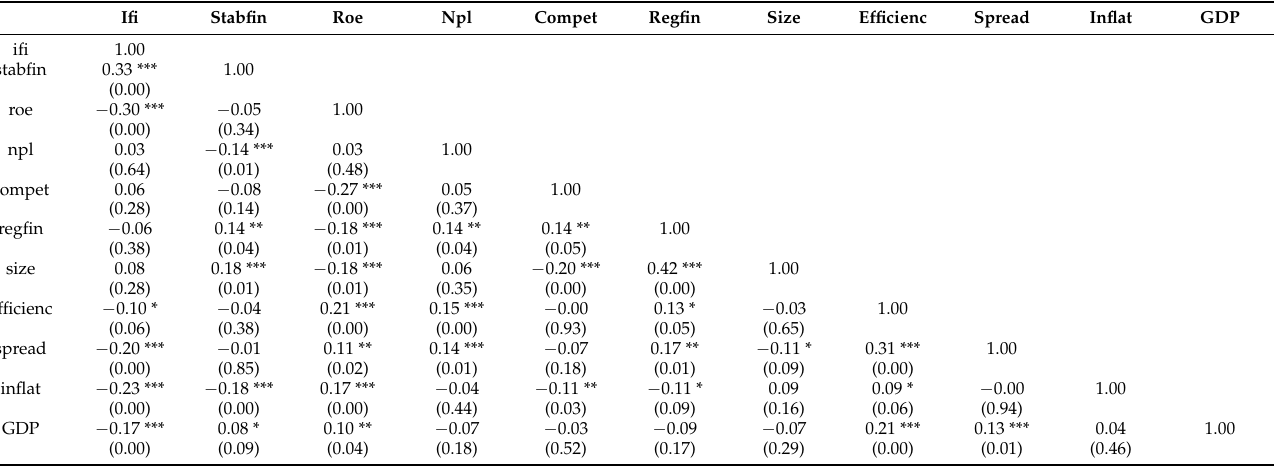
Table A5. Correlation matrix for all variables included in the study sample of LAC